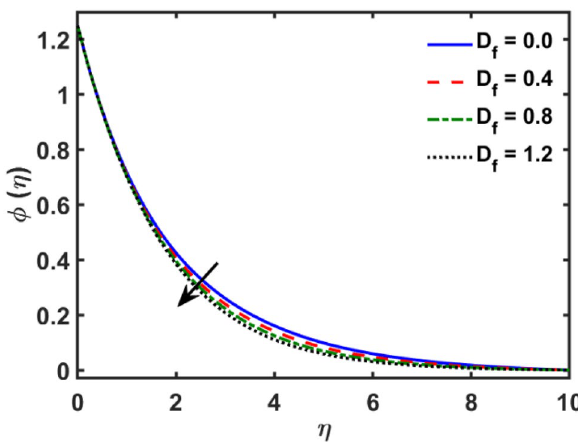
Figure 14. Variation of D f on φ(η) .